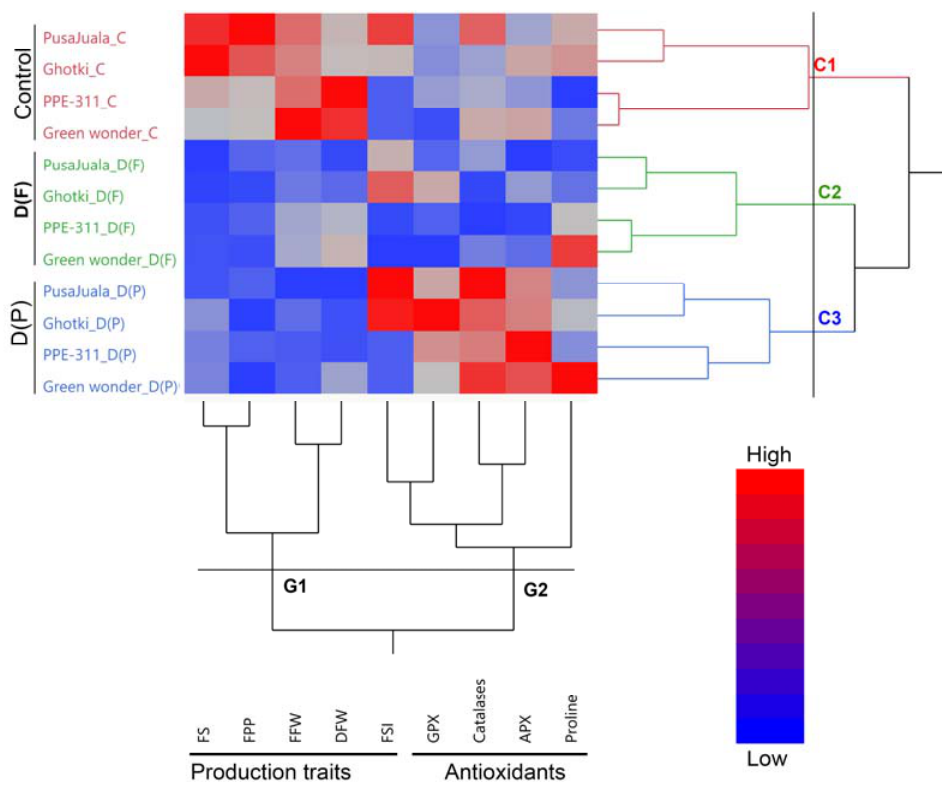
Figure 1. Hierarchical clusters and dendrogram of pepper genotypes and studied traits. Hierarchical clusters indicating three major clusters, including C1, C2, and C3 of pepper genotypes, also indicate two major groups (G1 and G2) of studied triat.